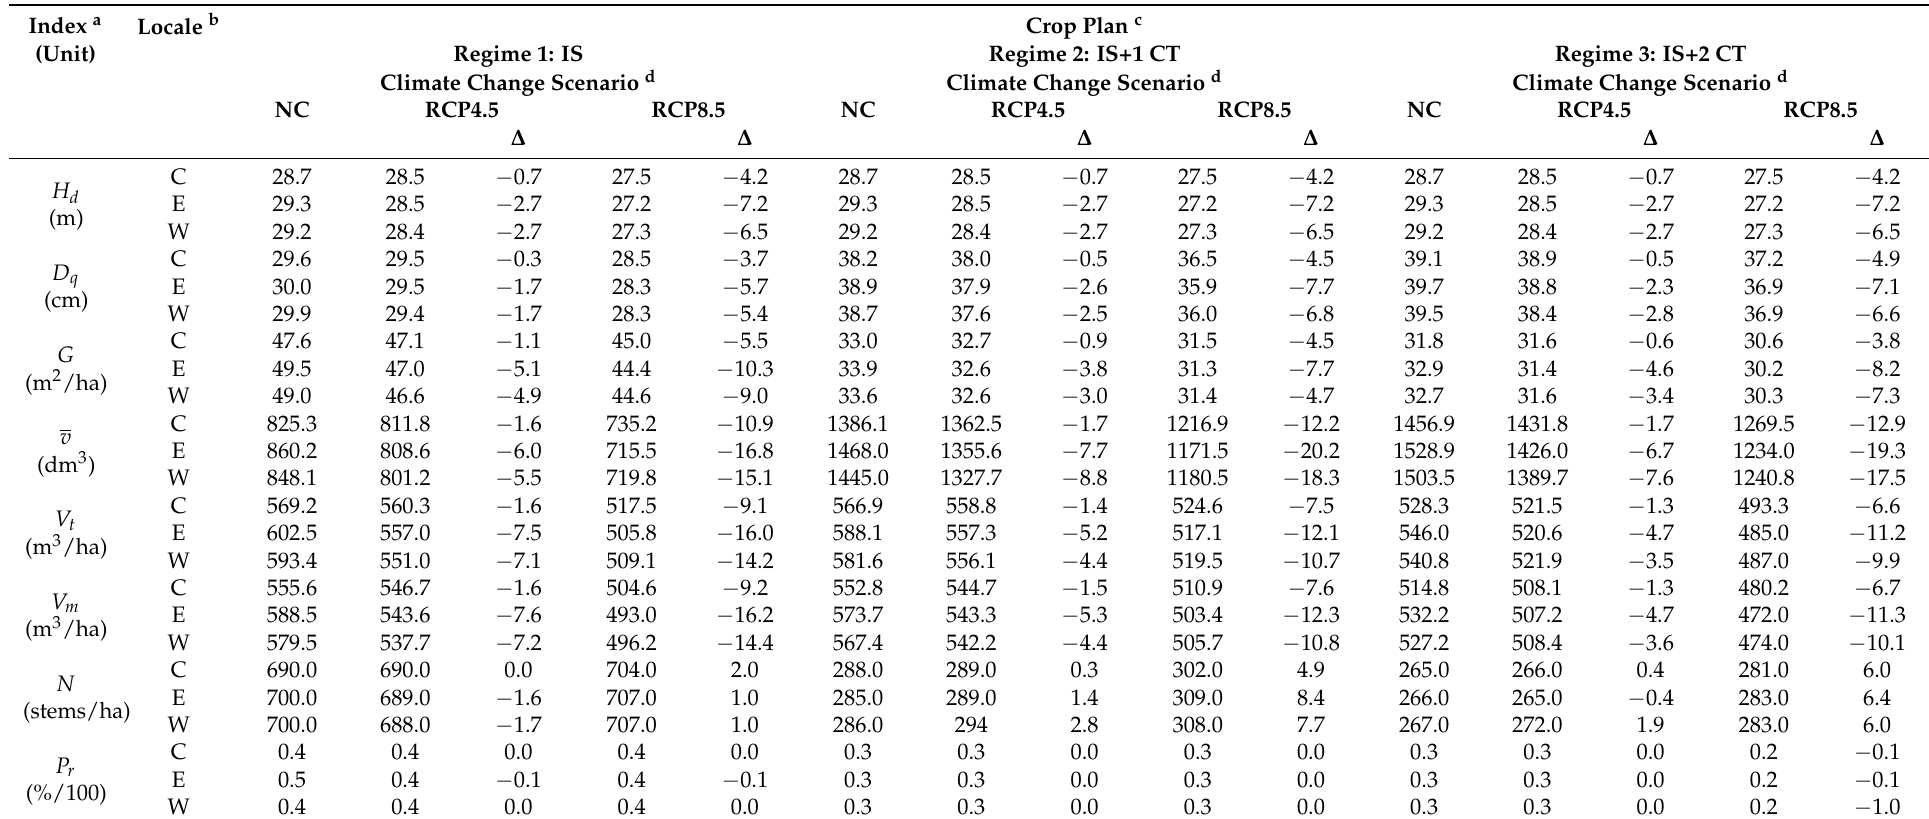
Table 3. Effects of climate change on SSDMM-derived rotational yield estimates for three red pine crop plans of increasing silviculture intensity at three geographic locales (north-central (Thessalon), north-eastern (Kirkland Lake) and north-western (Thunder Bay) Ontario): (1) initial spacing (IS) with no thinning (Regime 1); (2) IS with one commercial thinning (CT) treatment (Regime 2); and (3) IS with two CT treatments (Regime